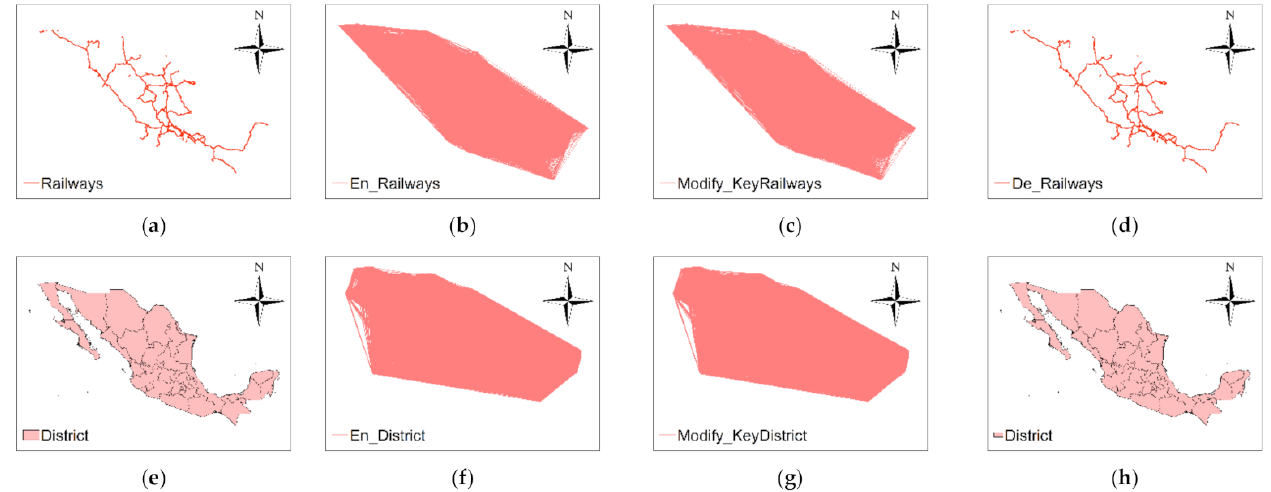
Figure 10. Key sensitivity. ( a ) The original “Railways” data; ( b ) cipher map using original key; ( c ) decrypted map using incorrect key; ( d ) decrypted map using correct key; ( e ) the original “District” data; ( f ) cipher map using original key; ( g ) Decrypted map using incorrect key; ( h ) Decrypted map using correct key.